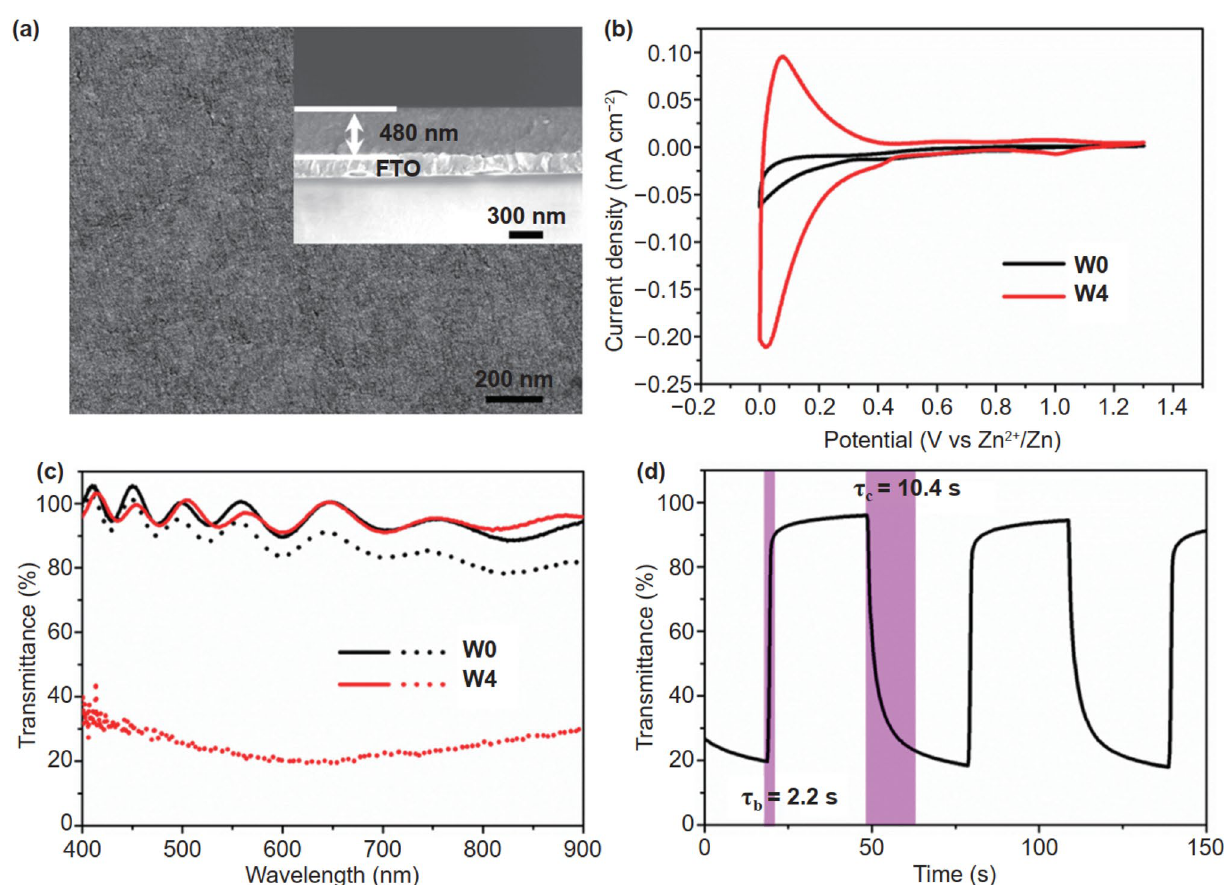
Fig. 2 Characterizations of W-doped TiO 2 NC films. a Surface and cross-sectional (inset) SEM images of a W4 film. b Voltammograms of the TiO 2 and W4 NC films at 1 mV s −1 in the 0–1.3 V (vs. Zn 2+ /Zn) window in 1 M ZnSO 4 aqueous electrolyte. c Optical transmittance spectra of the TiO 2 and W4 NC films at fully colored (dot lines) and bleached (solid lines) states. d In situ optical transmittance of a W4 NC film at 550 nm in potential steps of 0–1.3